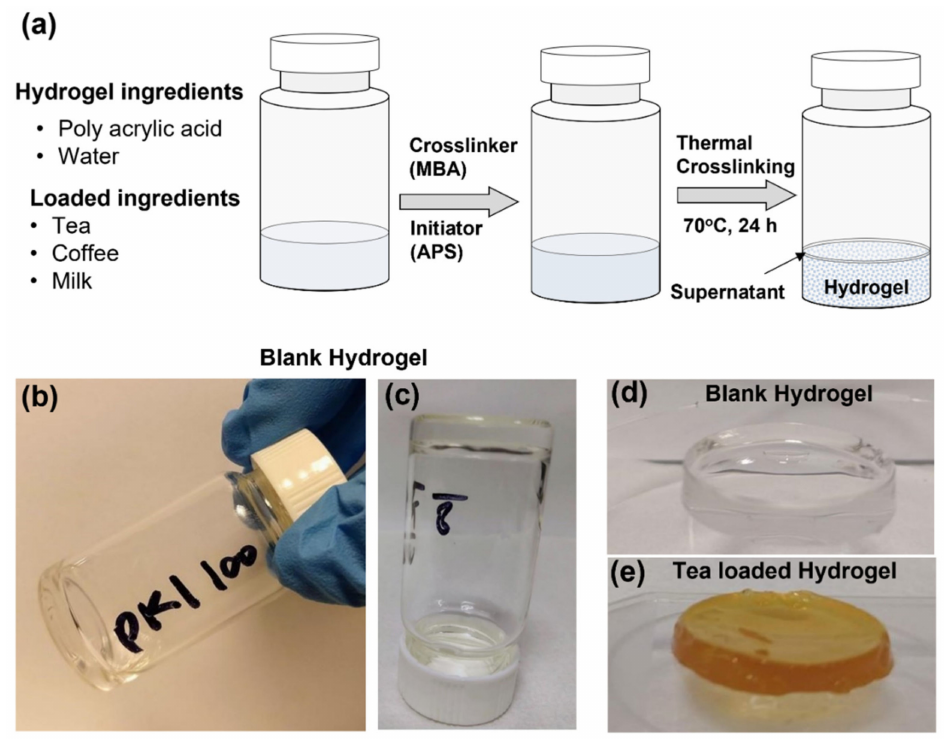
Figure 3. ( a ) Schematic of the hydrogel preparation process. ( b – d ) shows blank hydrogel formulae D (Table S1). ( e ) show the image of tea-loaded